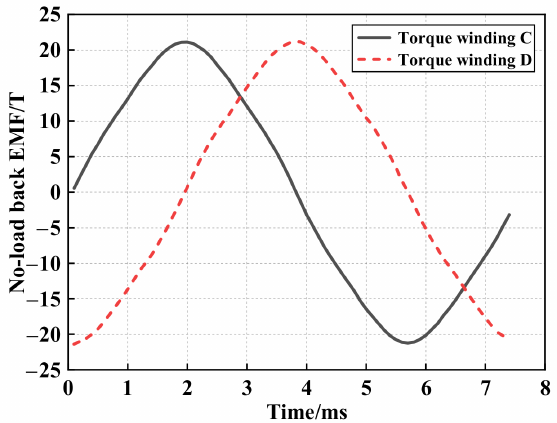
Figure 6. The largest back EMF in the structural parameter interval.